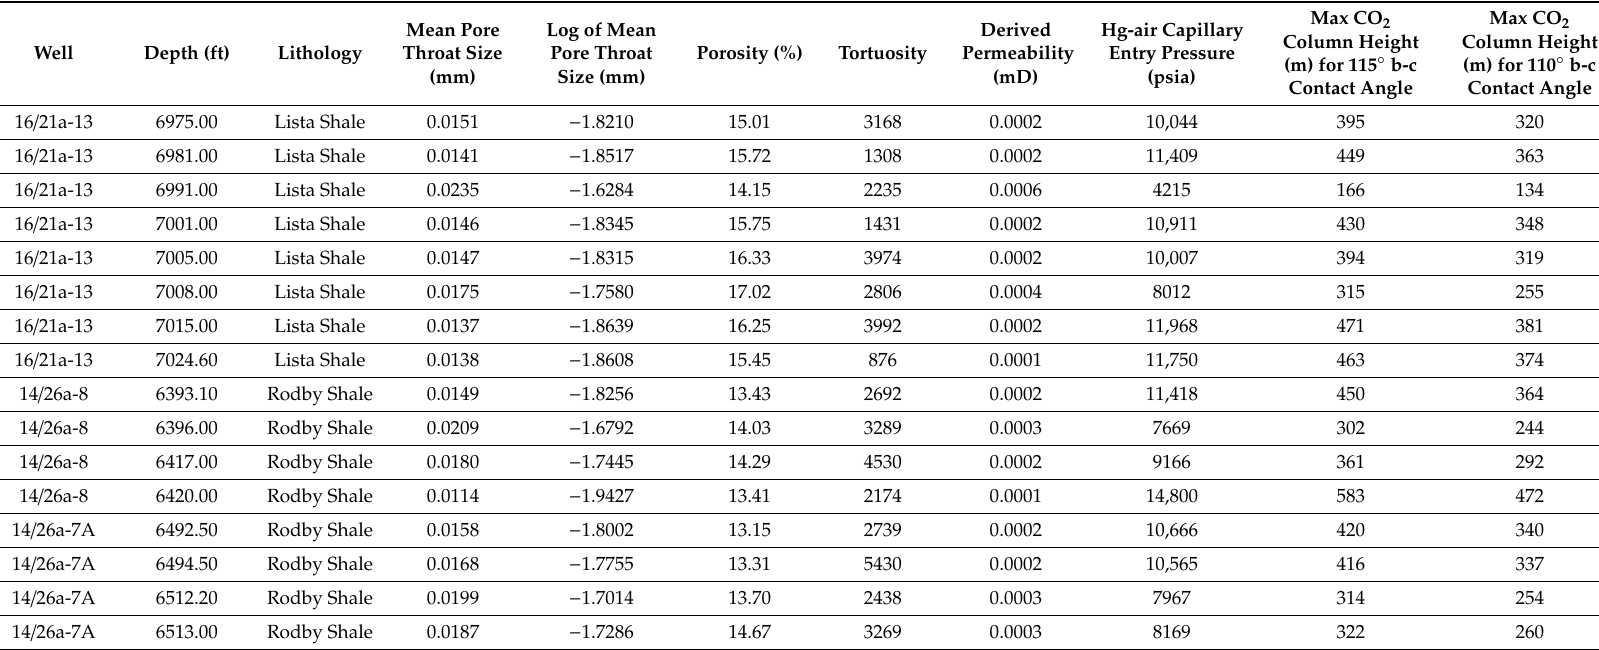
Table 2. Summary of results from mercury intrusion porosimetry from the Lower Cretaceous Rodby Shale and the Palaeocene Lista Shale. Permeability was derived using methods in Swanson [28]. Pore size distributions are presented graphically in Figure 8. Equation (7) was used to derive threshold pressure values for the brine–CO 2 system based on the lab-derived mercury air with an assumed interfacial tension for brine–CO 2 of 0.021 N / m. The derivation of the maximum CO 2 column height was undertaken using Equation (8). Brine density was assumed to be 1.05 g / cm 3 for both Acorn and East Mey sites, based on regional data in Warren and Smalley [17]. CO 2 density was assumed to be as 0.65 g / cm 3 based on Salem and Shedid [31]. The brine–CO 2 contact angle was assumed to be 115 ◦